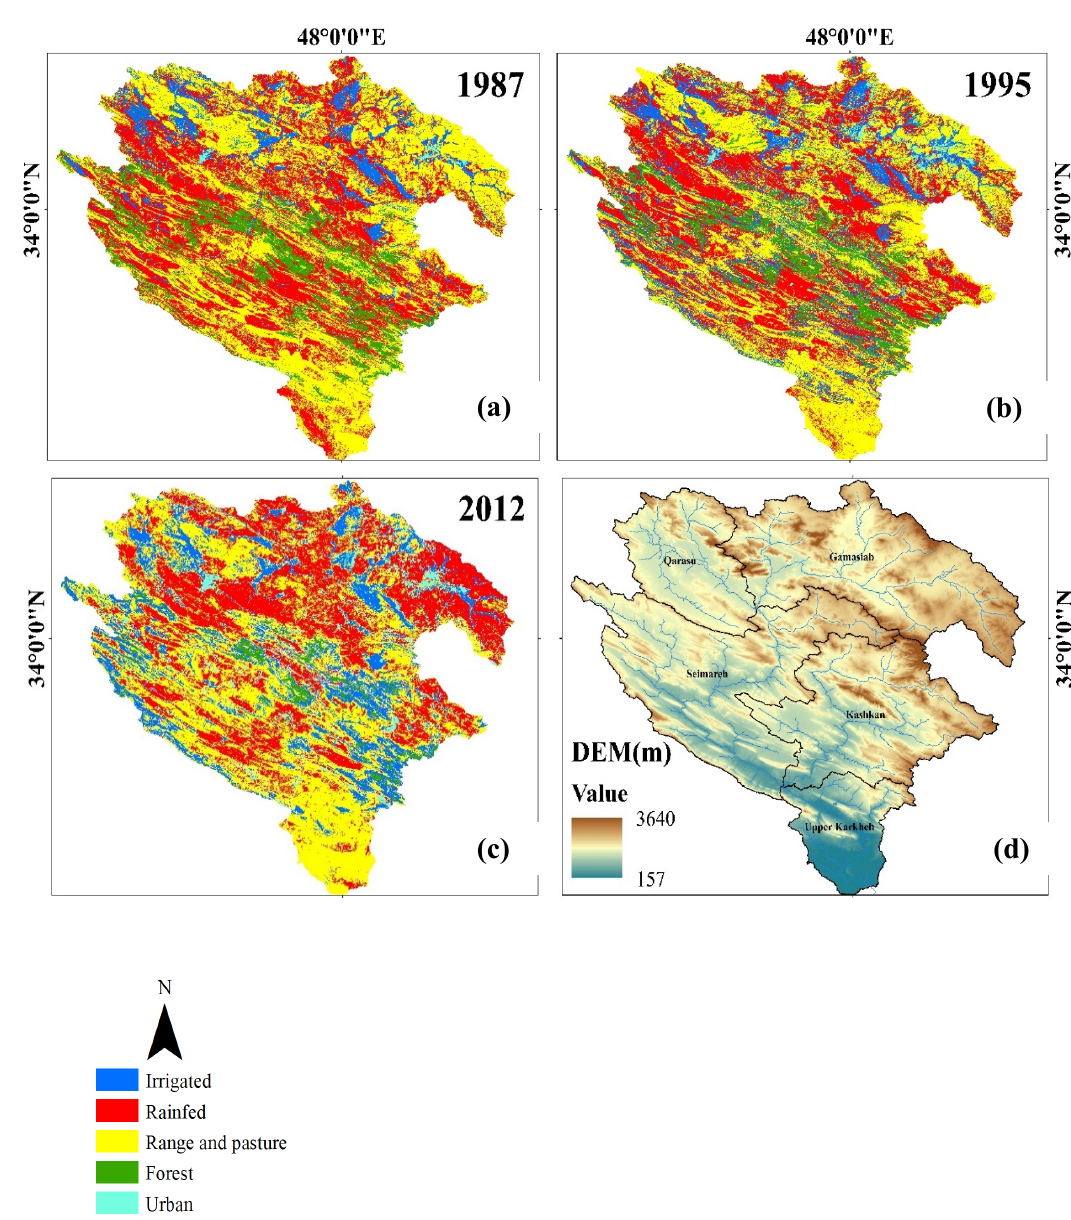
Figure 5. Land use maps for the KRB, ( a ) before breakpoint (1987), ( b ) in transition (1995), and ( c ) after breakpoint (2012), and ( d ) the digital elevation map.